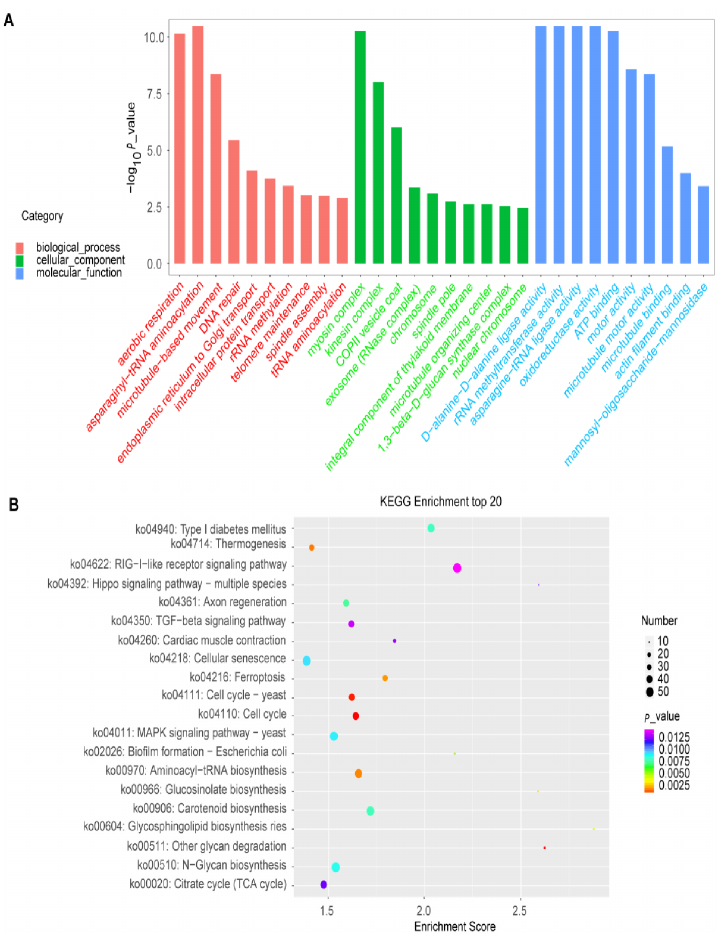
Figure 8. GO and KEGG analyses performed on the ARF39. ( A ), GO analysis displaying the top 20 enriched pathways for the biological process, cellular component, and molecular function. ( B ), KEGG analysis displaying the top 20 enriched metabolic pathways based on the ARF39